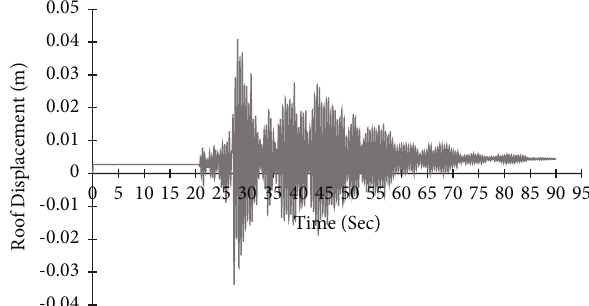
Figure 28: Displacement histories of the glulam braced portal